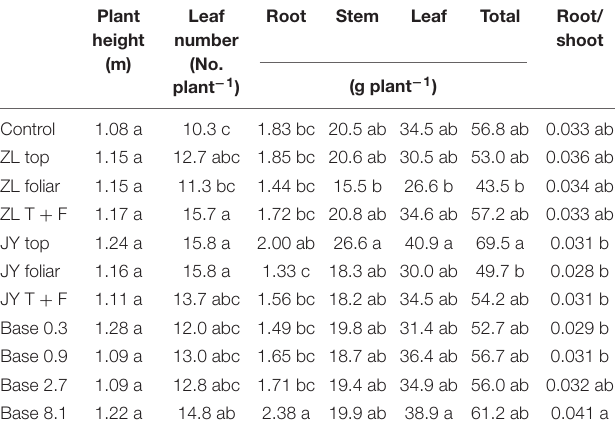
TABLE 4 | The effect of fulvic acids on plant height, leaf number, and dry matter of stem, leaf, and the entire plants of tomato plants cv. Hezuo906 grown in the soil culture for 126 days from transplanting (Experiment